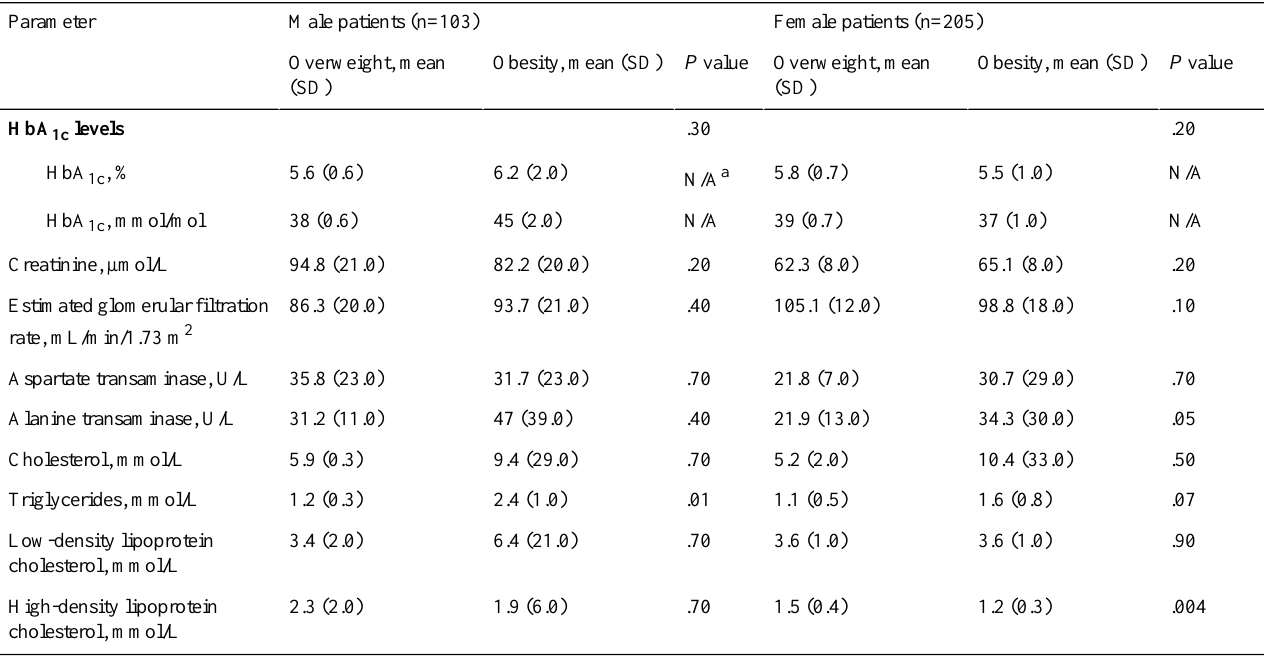
Table 2. Laboratory parameters compared between male and female patients with overweight and those with obesity (N=308).